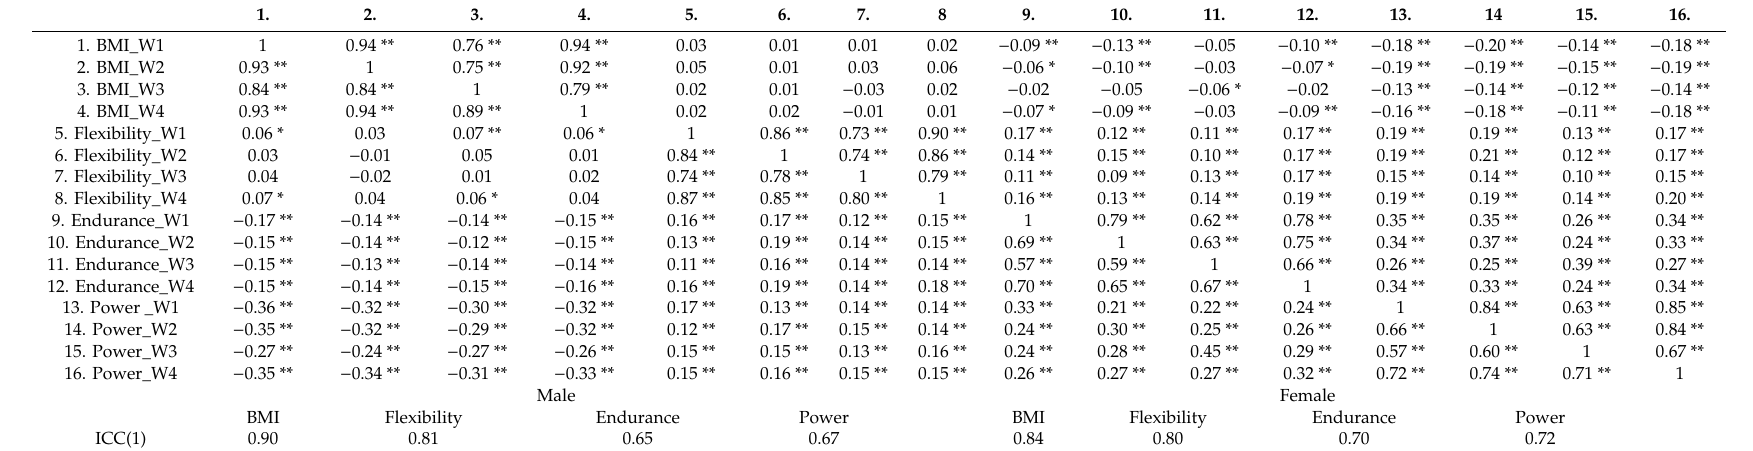
Table 3. Coe ffi cients of BMI, flexibility, muscular endurance, and explosive power with normal / overweight / obese weight status and inter-class correlation coe ffi cients